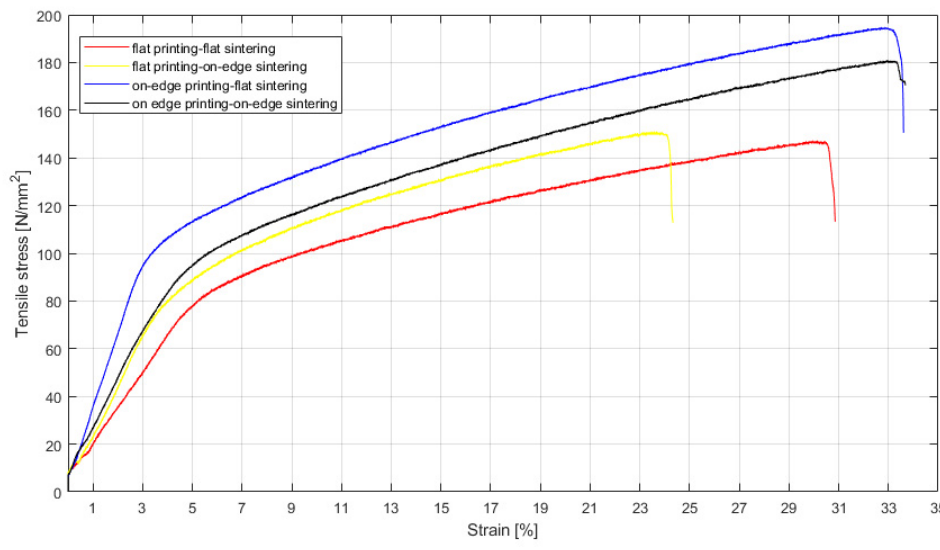
Figure 9. Tensile stress–strain curves of metal parts from test No. 1, 2, 4, and 5 in Table 3.